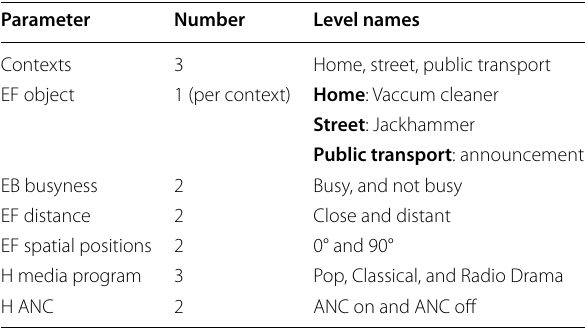
Table 1 List of parameters for the experiment along with the number of choices and the level